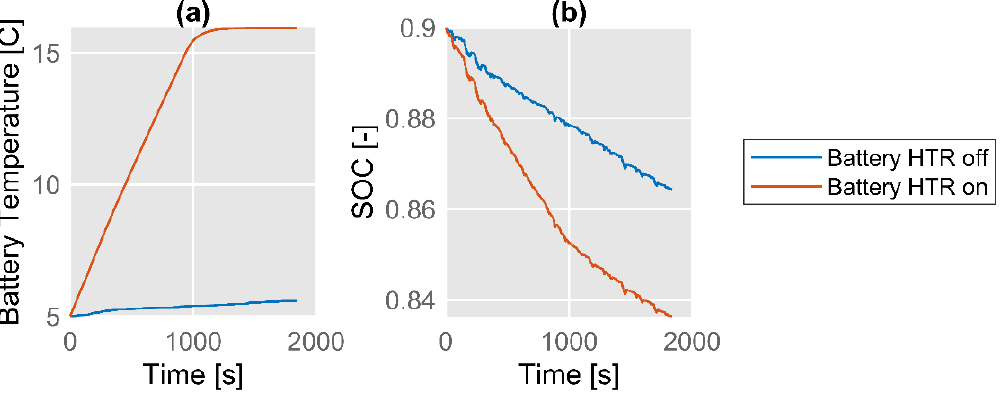
Figure 18. ( a ) Battery temperature and ( b ) SOC variation throughout time for a one-way journey of the L18.